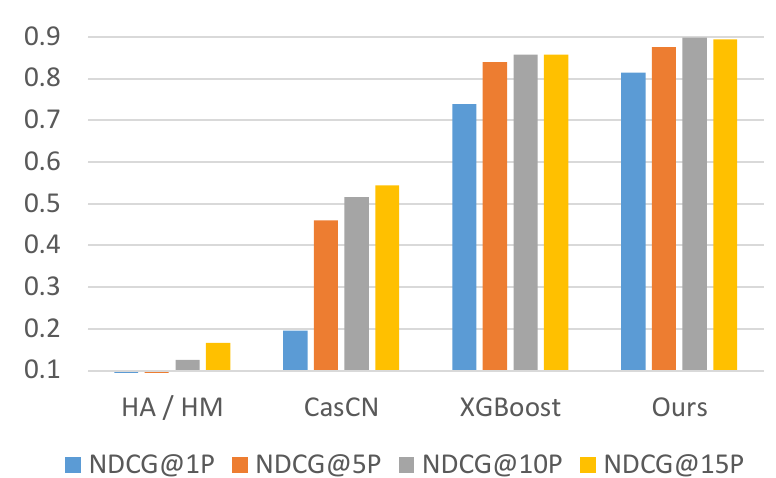
Figure 9. Comparison of performance for